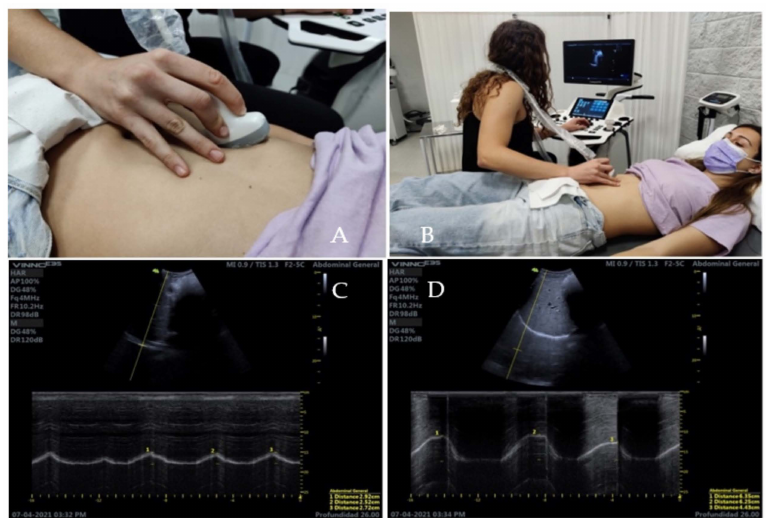
Figure 2. Ultrasound image of diaphragmatic excursion measurement in TV ( A ) and FV ( B ). ( A ) demonstrates transducer placement for an anterior subcostal projection placed between the anterior axillary and mid-clavicular lines. ( B ) represent the subject and examiner position. ( C ) corre- sponds to the diaphragmatic excursion when breathing in TV. ( D ) corresponds to the diaphragmatic excursion when breathing in